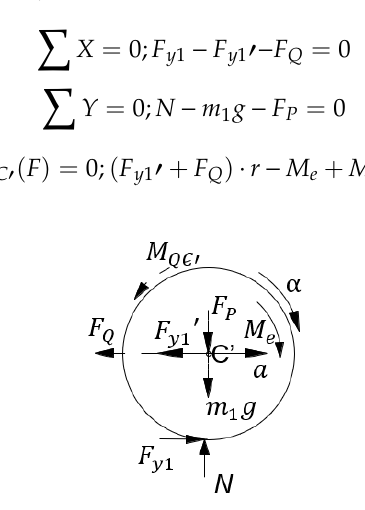
Figure 5. Force analysis of drive wheel 1.